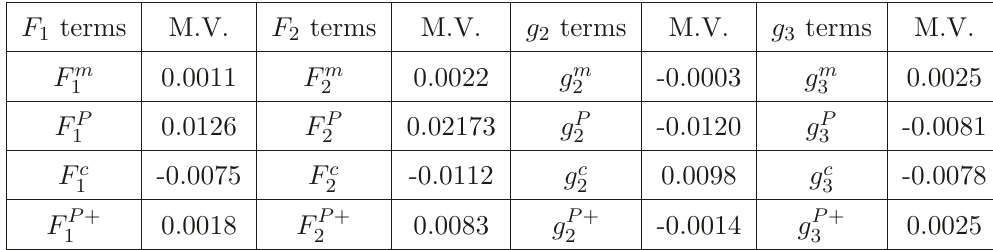
Maximum values (M.V.) (or minimum values wherever there is a negative sign) of the curves depited in figures 3, 4, 5 and 6. We have set